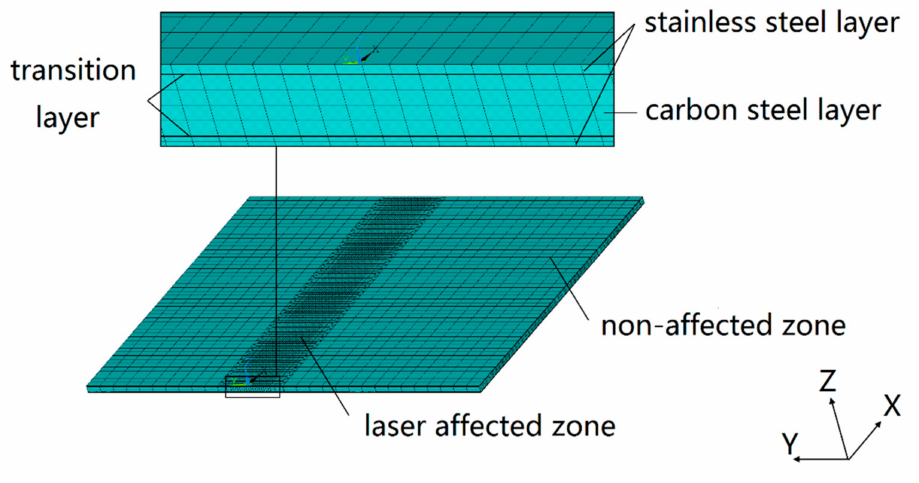
Figure 6. FEM grid partition profile of the